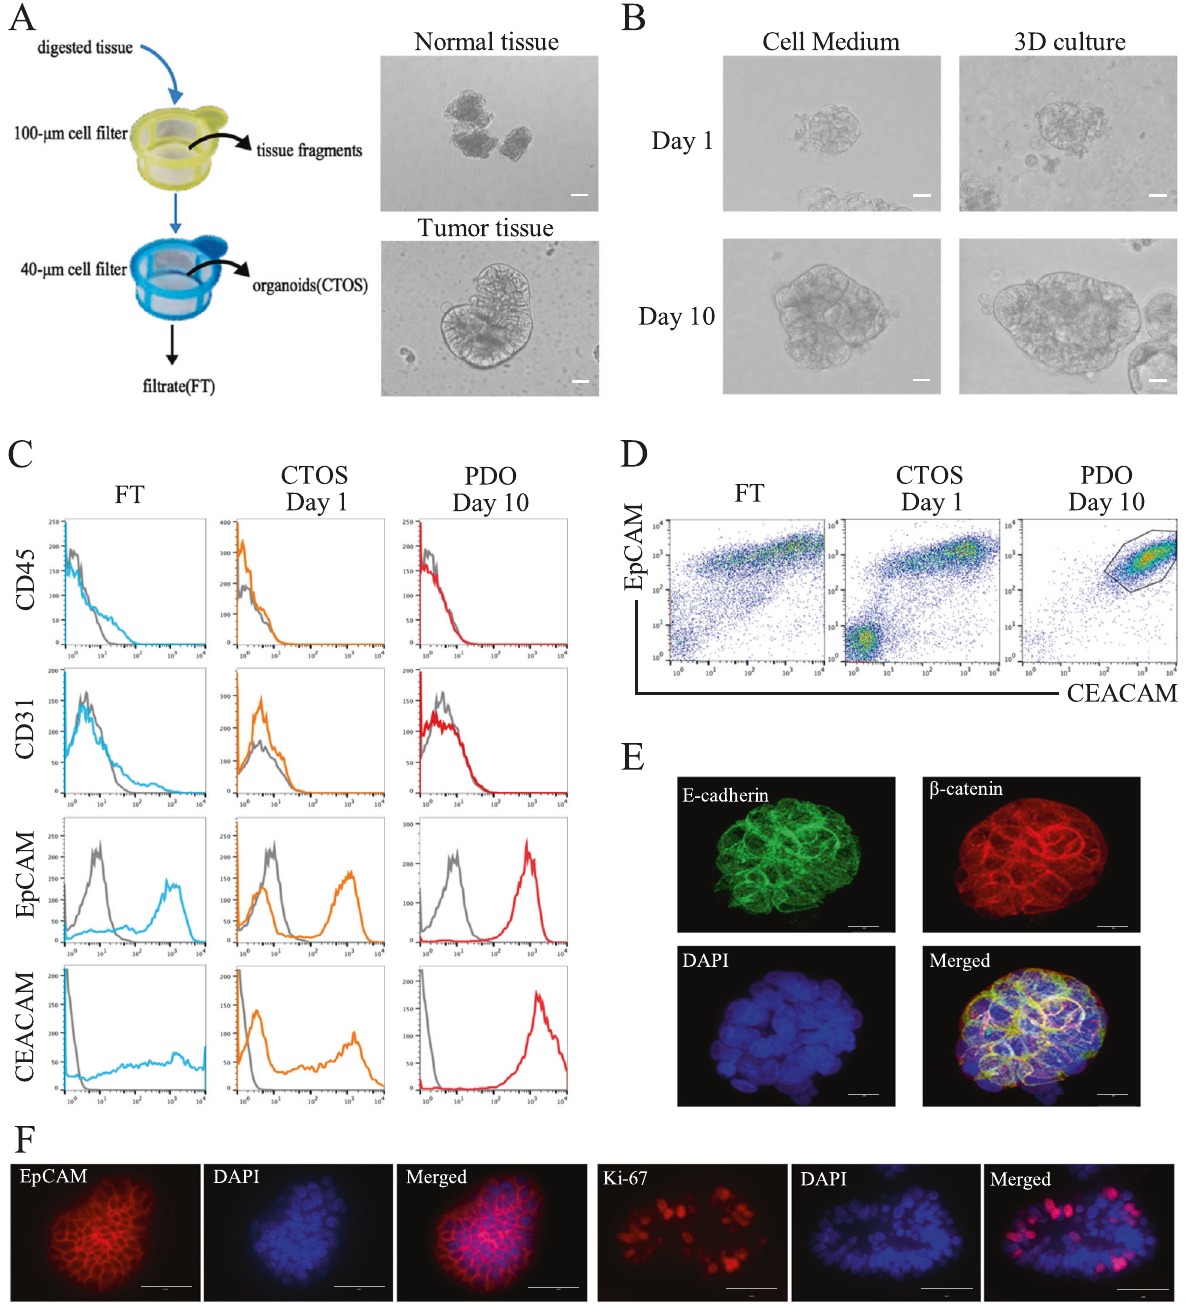
Fig. 1 Generation of patient-derived organoids from colorectal cancer. A Schematic diagram for the preparation of CRC PDOs. Only tumor samples can form PDOs, and normal cells died in a short time. Scale, 100 μ m. B The appearance of CRC PDO in suspension culture or 3D culture. Scale, 100 μ m. C , D Flow cytometry showed that the CRC PDOs were highly puri fi ed cancer cell clusters. E E-cadherin (green) and β -catenin (red) staining of PDOs. E-cadherin was located on the cell membrane and linked to β -catenin. Scale, 100 μ m. F PDOs expressed EpCAM and Ki-67. Scale, 200 μ m. Data represent the mean ±